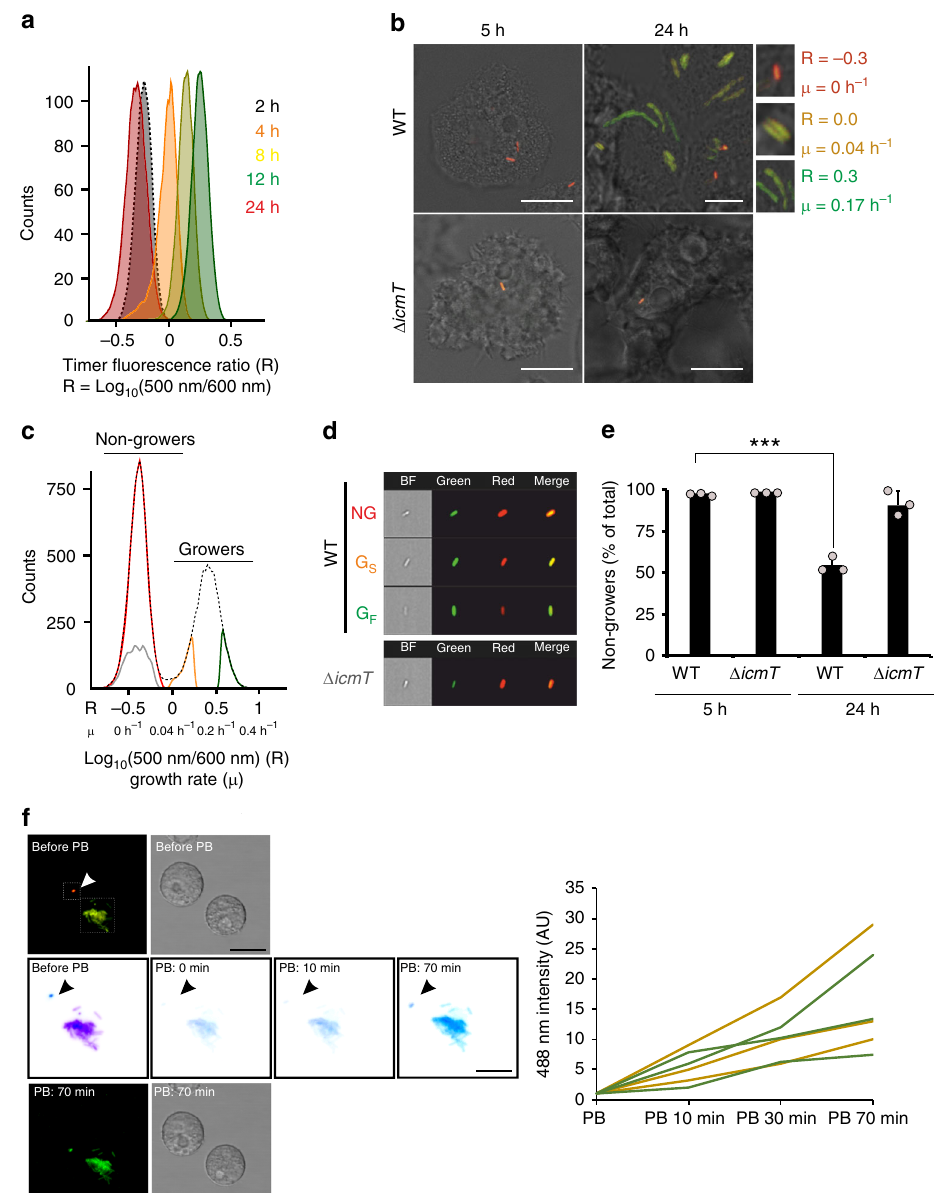
Fig. 1 L. pneumophila shows growth rate heterogeneity in infected amoebae. a Timer color ratio re fl ects the division rate at a single cell level. Stationary phase grown L. pneumophila/ Timer was diluted in AYE broth and let grow for 24 h. At given time points, bacteria were harvested and analyzed by fl ow cytometry. The Timer color ratio - Log 10 [500 nm (green)/600 nm (red)] - was calculated for individual bacteria. b – d L. pneumophila intracellular growth rate heterogeneity. b Confocal microscopy of A. castellanii infected (MOI 1; 5, 24 h) with L. pneumophila /Timer wild-type (WT) or the isogenic avirulent Δ icmT /Timer strain. Micrographs show overlays of bright fi eld and the Timer fl uorescence (500 nm and 600 nm); growing and nongrowing bacteria appear green or red/orange, respectively. Magni fi cations: growth rate heterogeneity of L. pneumophila subpopulations (24 h p.i.) with different color ratios (R: Log 10 [green/red] color ratio) and the corresponding division rate ( μ ). Scale bars 10 μ m. c Flow cytometry or d imaging fl ow cytometry of lysed infected A. castellanii shows growth rate heterogeneity of released intracellular bacteria. Black, whole population; red, nongrowers (NG); orange, slow-growers (G S ); green, fast-growers (G F ). gray, Δ icmT . BF, Bright fi eld. e L. pneumophila forms a high percentage of nongrowers in infected Acanthamoebae . Quanti fi cation by fl ow cytometry of nongrowing L. pneumophila /Timer wild-type (WT) or Δ icmT /Timer in infected cell lysates (MOI 1; 5, 24 h). f Intracellular nongrowers produce Timer protein de novo. A. castellanii was infected (MOI 1, 24 h), L. pneumophila /Timer and immobilized in PYG/0.1% agarose. Photobleaching (PB) was set up using the FRAP-wizard algorithm of the Leica SP8 microscope. Regions of interest (ROI; dashed squares) were photobleached (100% 488 nm laser intensity, iteration 30×), and fl uorescence recovery at 500 nm was recorded (every 10 min). Micrographs illustrate FRAP kinetics in inverted color for clarity. Scale bar 20 μ m. Fluorescence recovery measurements shown for three nongrowers (yellow) and three growing bacterial clusters (green). Data represent the mean ± SEM of three biological replicates ( n = 3; light gray fi lled circles). Student ’ s t test two-tailed, *** P < 0.001. Source data are provided as a Source Data fi